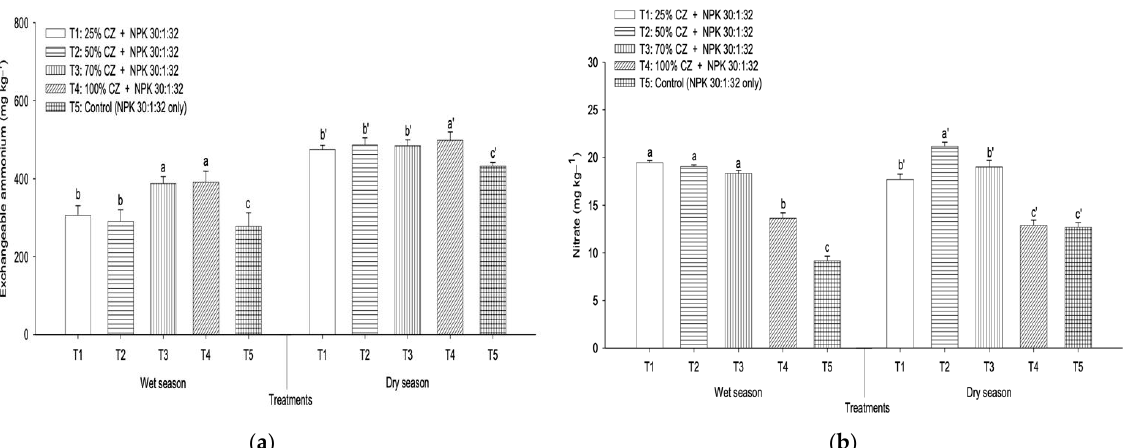
Figure 4. Effects of clinoptilolite zeolite and nitrogen, phosphorus, and potassium fertilization on mean retention of ( a ) soil exchangeable ammonium and ( b ) available nitrate in the wet and dry seasons. Means with different letters indicate significant differences between treatments according to Tukey’s test at p ≤ 0.05. Error bars represent standard error of the mean. CZ: clinoptilolite zeolite. Letters without primes represent the wet season and single primes represent the dry season.